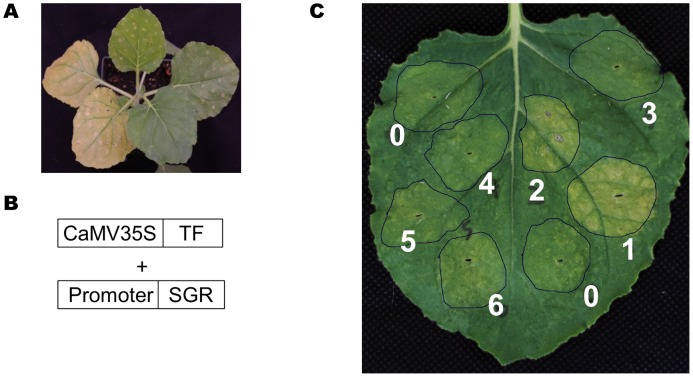
A TF-promoter screening system based on the SGR gene.(A) Transient overexpression of the SGR gene (left two leaves) in N. benthamiana induced yellowing, while a control gene did not (two leaves, upper right). (B) The design scheme for the screening system. (C) Transient over-expression of the SUR_Promoter::SGR construct together with 6 different MYBs (#1 to #6), and an actin gene as negative control (#0). Only MYB28 (#1), MYB29 (#2) induced yellowing.